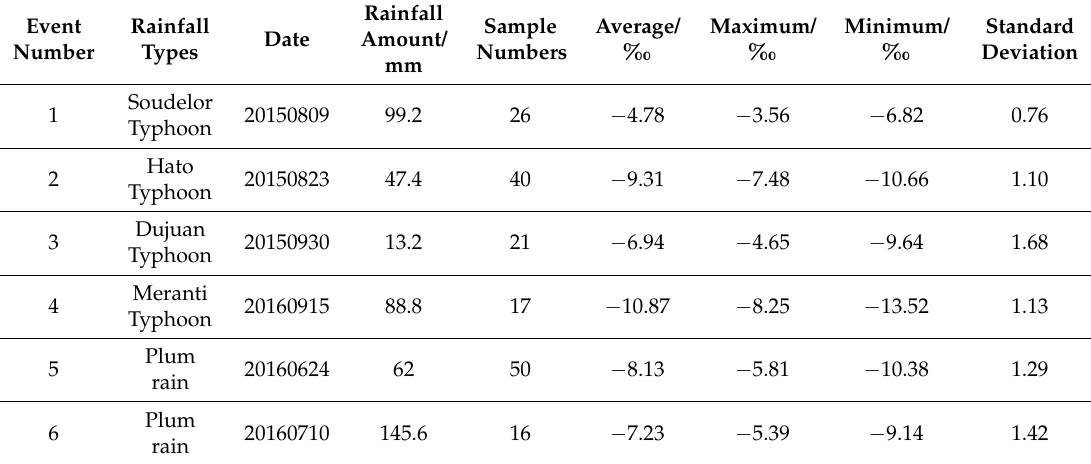
Table 1. δ 18 O values in precipitation for six selected rainfall events (the column “date” 20150809 indicates the flood starting time on the 9 August